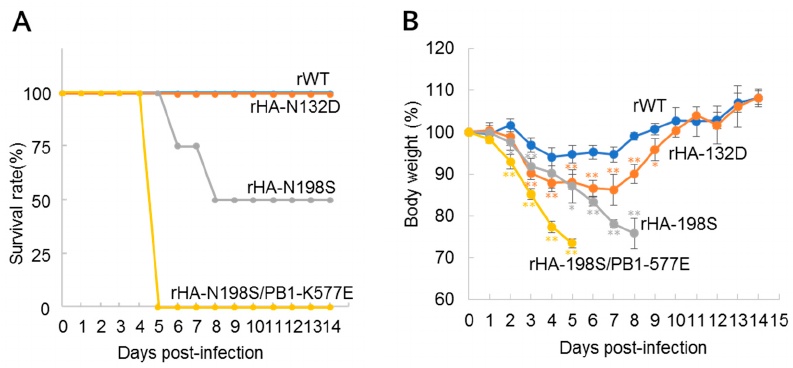
Figure 2. Pathogenicity of hemagglutinin (HA) mutant viruses in mice. Six-week-old female BALB/c mice ( n = 4 per group) were inoculated intranasally with 10 5 PFU of rWT, HA mutant (rHA-N132D, rHA-N198S), or double mutant (rHA-N198S/PB1-K577E) virus. ( A ) Mortality and ( B ) body weight changes of the virus-inoculated mice were assessed for 14 days. Mice that showed a more than 25% body weight loss were euthanized and scored. Significant body weight changes of the mutant virus-infected mice compared with rWT-inoculated mice ( p < 0.05 or p < 0.01, Student’s t -test, two-tailed analysis) are indicated by an asterisk (*) or two asterisks (**), respectively.